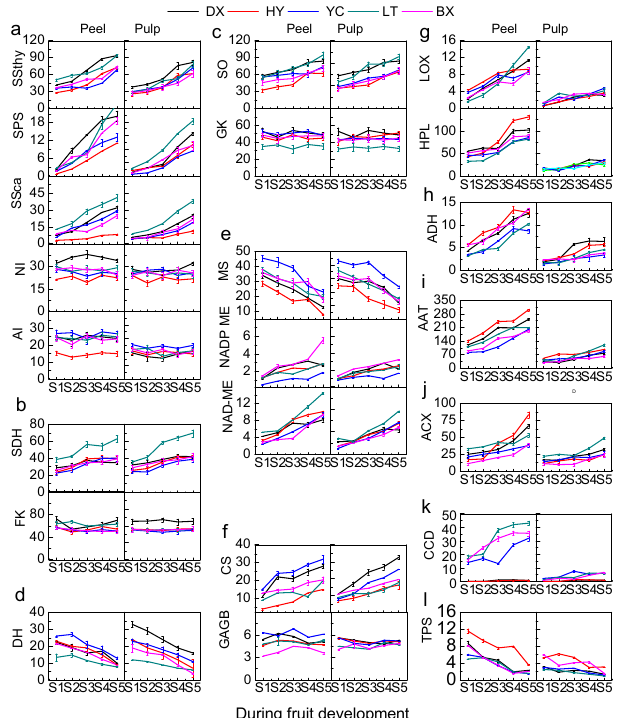
Figure 7. The flavor compound-related enzyme activities (U/mg protein) of apricot fruit during development and ripening. ( a ) SSthy, sucrose synthase for synthesis direction, SPS, sucrose phosphatesynthase, SSca, sucrose synthase for degradation direction, NI, neutral invertase, AI, acid invertase; ( b ) SDH, sorbitol dehydrogenase, FK, fructokinase; ( c ) SO, sorbitol oxidase, GK, glucokinase; ( d ) DH, quinate dehydrogenase; ( e ) MS, malate synthase, NADP-ME, NADP-malic enzyme, NAD-ME, NAD-malic enzyme; ( f ) CS, citrate synthase, GAD, glutamate decarboxylase; ( g ) LOX, lipoxygenases, HPL, hydroperoxide lyase; ( h ) ADH, alcohol dehydrogenase; ( i ) AAT, alcohol acyl-transferases; ( j ) ACX, acyl-CoA Oxidase; ( k ) CCD, carotenoid cleavage dioxygenases; ( l ) TPS, terpene synthase. Two capital letters in the top are the cultivars shown in Table 1. All data are expressed as means ± standard error of triplicate samples.